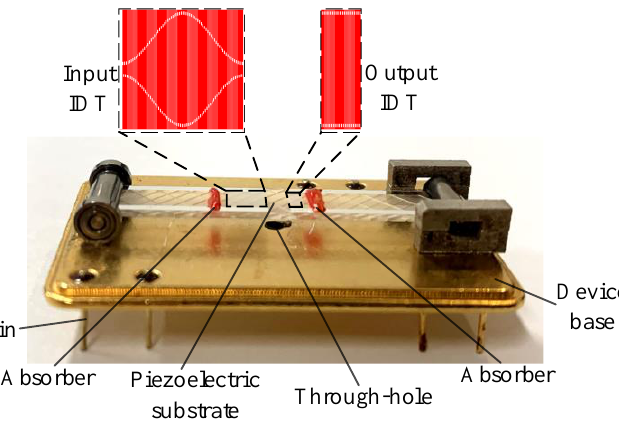
Figure 9. The simply supported beam SAW yarn tension sensor.